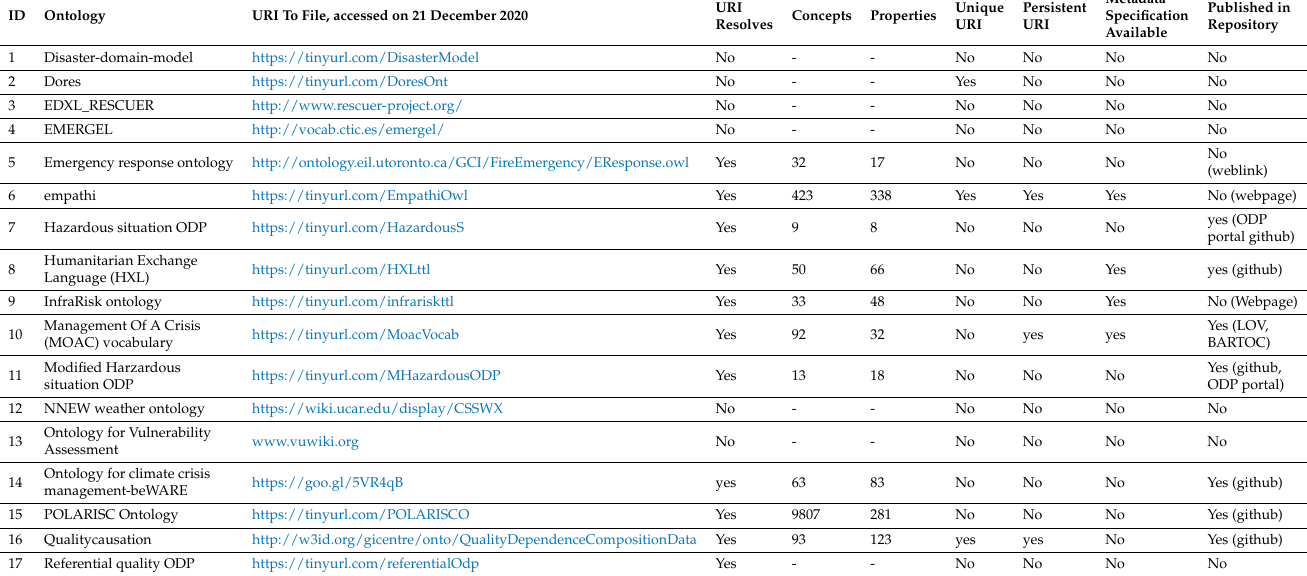
Table 6. Ontologies with URIs in the Disaster Domain.